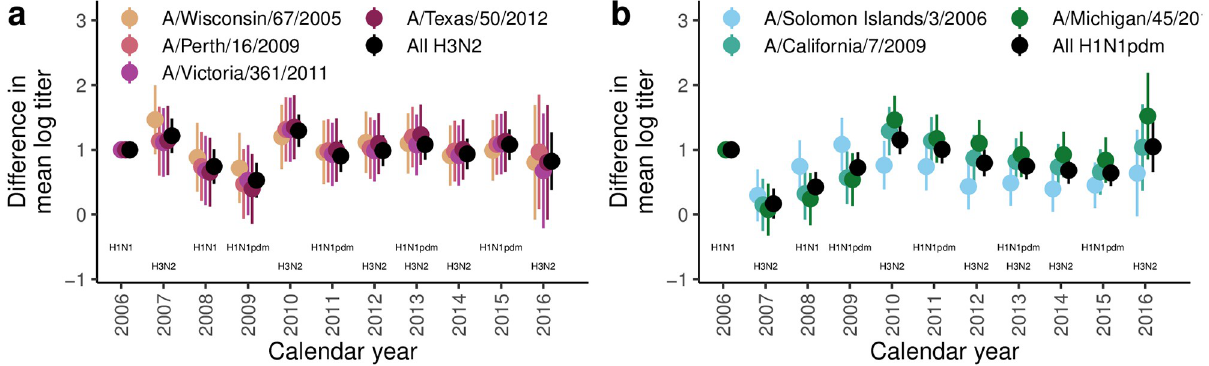
Fig 6. Period (calendar year) effects on HAI titers. Difference in mean log titer relative to 2006 for a) the H3N2 strain-specific and subtype-specific models and b) the H1N1 strain-specific and seasonal vs pandemic strain models. In each plot, the bars give the 95% confidence intervals.